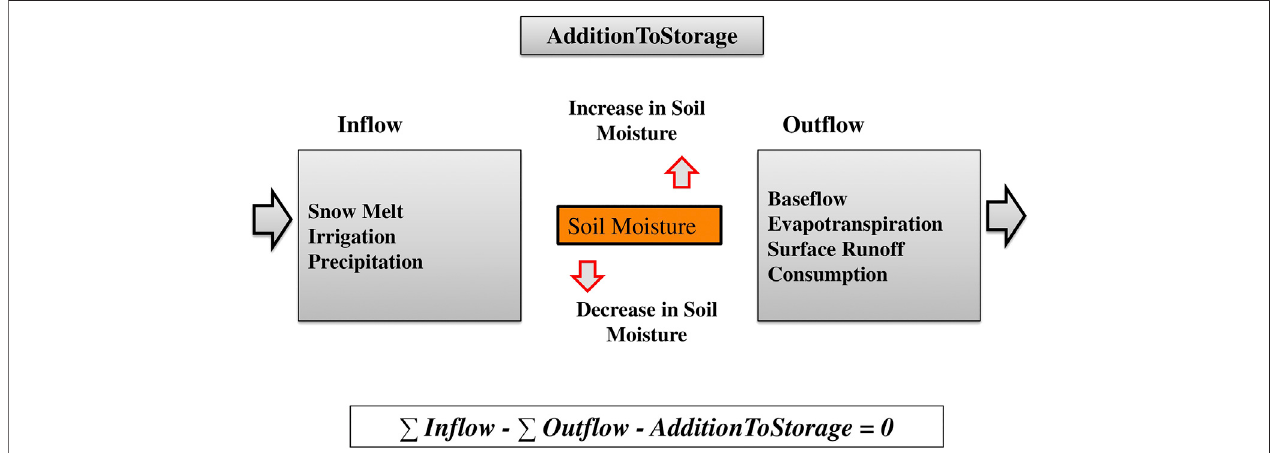
FIGURE 2 | Water balance diagram of the WEAP model.